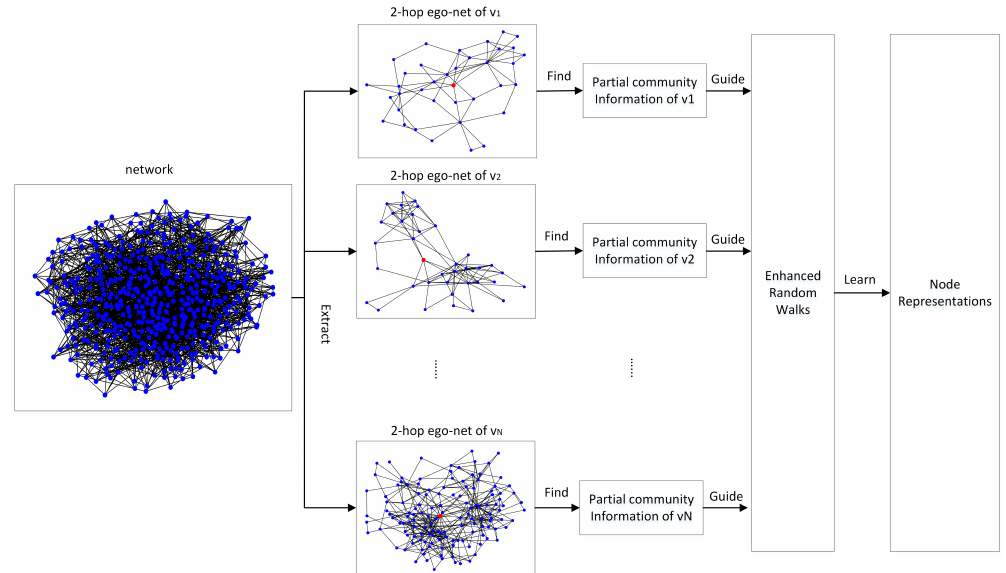
Figure 1. The Conception Structure of